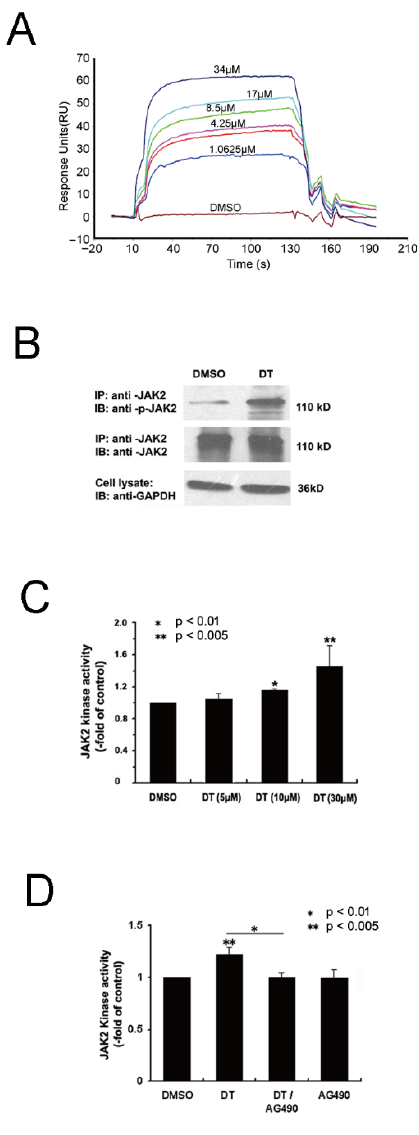
Figure 7. JAK2 as the protein target of DT. SPR analyses of JAK2 binding to DT. Normalized sensor grams using the JAK2 protein as the ligand and the DT as the analyte are shown. The concentrations of DT were 0, 1.0625, 2.125, 4.25, 8.5, 17, and 34 µ M. The raw data (colored lines) were fitted to a 1:1 binding model (black lines) ( A ). NSC cultures pretreated with DT or DMSO (control) for 24 h were immunoprecipitated (IP) with anti-JAK2, and then immunoblotted (IB) with anti-JAK2 or anti- phospho-JAK2. An equal proportion of cell lysate was also set to detect GAPDH for input control. The representative image shows an increase in JAK2 phosphorylation in DT-treated cells in contrast to control ( B ). In vitro JAK2 kinase assay shows DT from 5 µ M to 30 µ M has a concentration-dependent effect on JAK2 activity. Data shown are the mean ± S.D. from three independent experiments. *, p < 0.01, **, p < 0.005 by Student’s t test ( C ). In vitro JAK2 kinase assay by colorimetric ELISA shows JAK2 kinase pre-incubated with DT (17 μ M), DMSO, AG490 (200 nM) or DT (17 μ M) plus AG490 (200nM) has different catalytic abilities with its substrate. JAK2 kinase activities are normalized with an absorbance at 450 nm to that of the controls. Data shown are the mean ± S.D from three inde- pendent experiments. *, p < 0.01, **, p < 0.005 by Student’s t-test ( D ). Using cell biochemistry and an in vitro kinase assay, respectively, we further inves- tigated whether DT could regulate JAK2 activity. Primary cultured NSCs were treated with DT or an equal amount of DMSO for control. After 24 h-treatment, cultures were lysed for Western blot analysis. As shown in Figure 7 B, in comparison to GADPH, there was little variance in JAK2 expression between DMSO and DT-treated cells; however, the